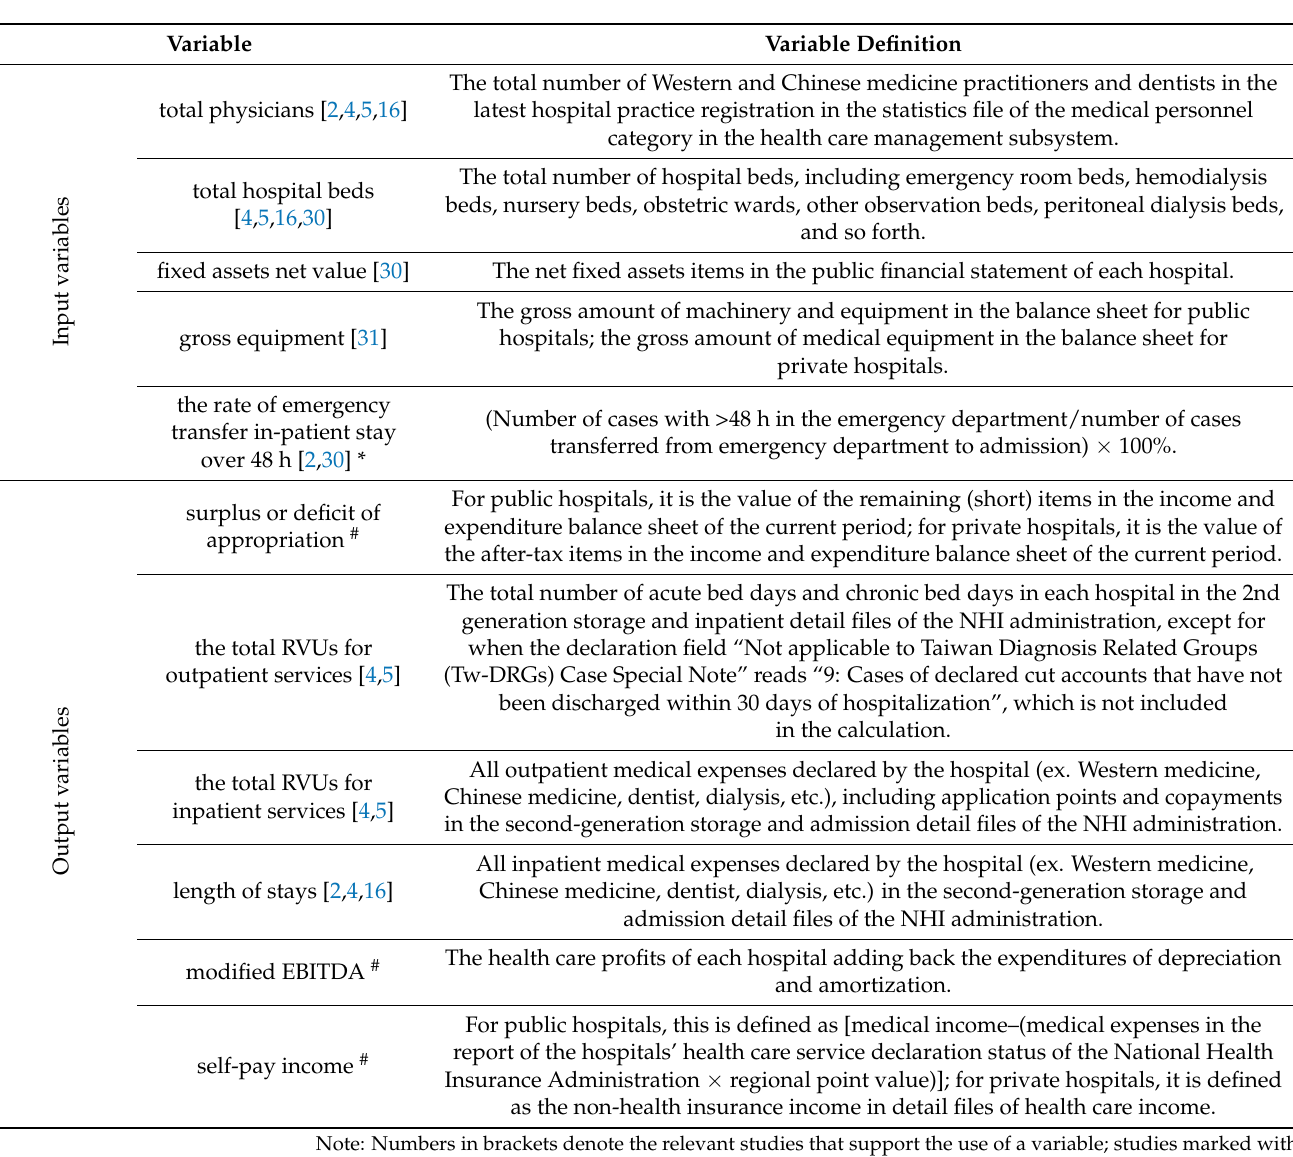
Table 1. The list of study input and output DEA